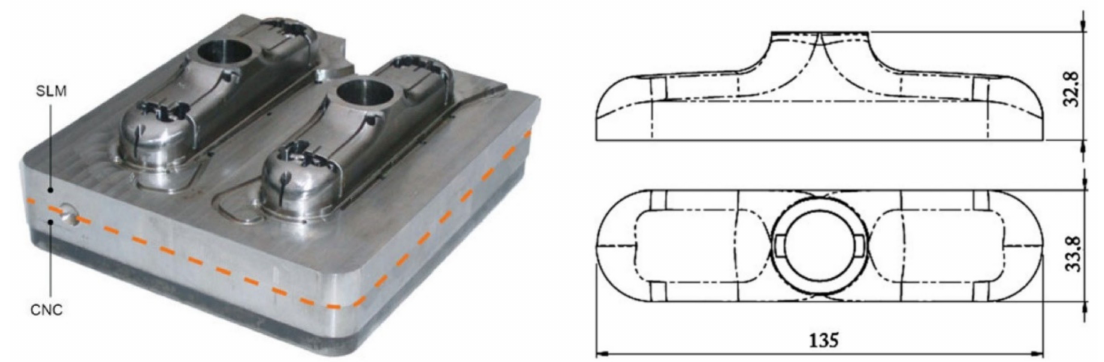
Figure 24. The impression block, a die for zinc alloy castings, was made by applying a hybrid approach. The upper piece was made by selective laser melting (SLM) or L-PBF from powders of AISI H11 (DIN 1.2343). The lower piece was built by CNC machining from a blank made of the same steel [136]. See also Figure 25. All displayed dimensions are in